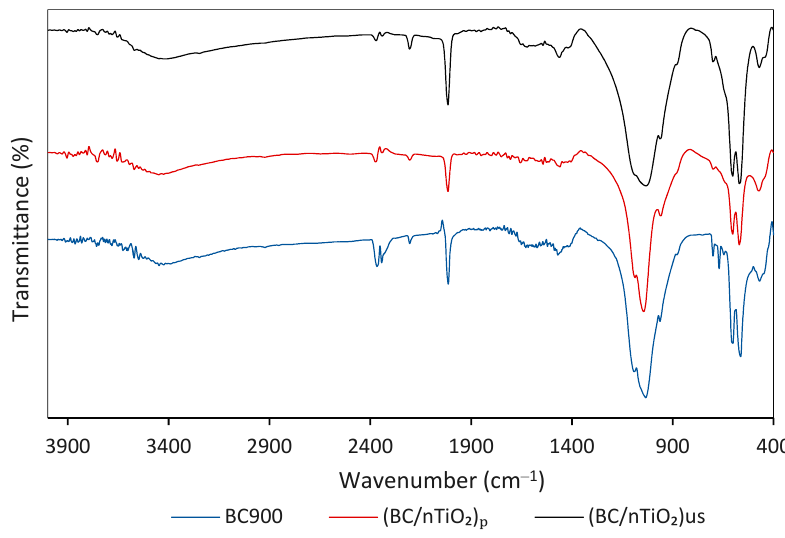
Figure 5. FTIR spectra of BC900 and its composites prepared following two different procedures.